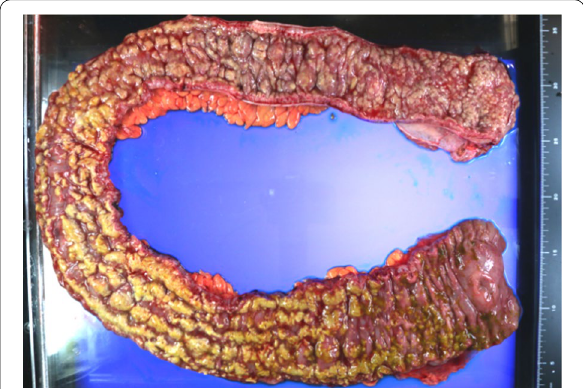
Fig. 3 The resected specimen has the highly edematous mucosa. A yellowish-white pseudomembrane is widely formed in a patchy